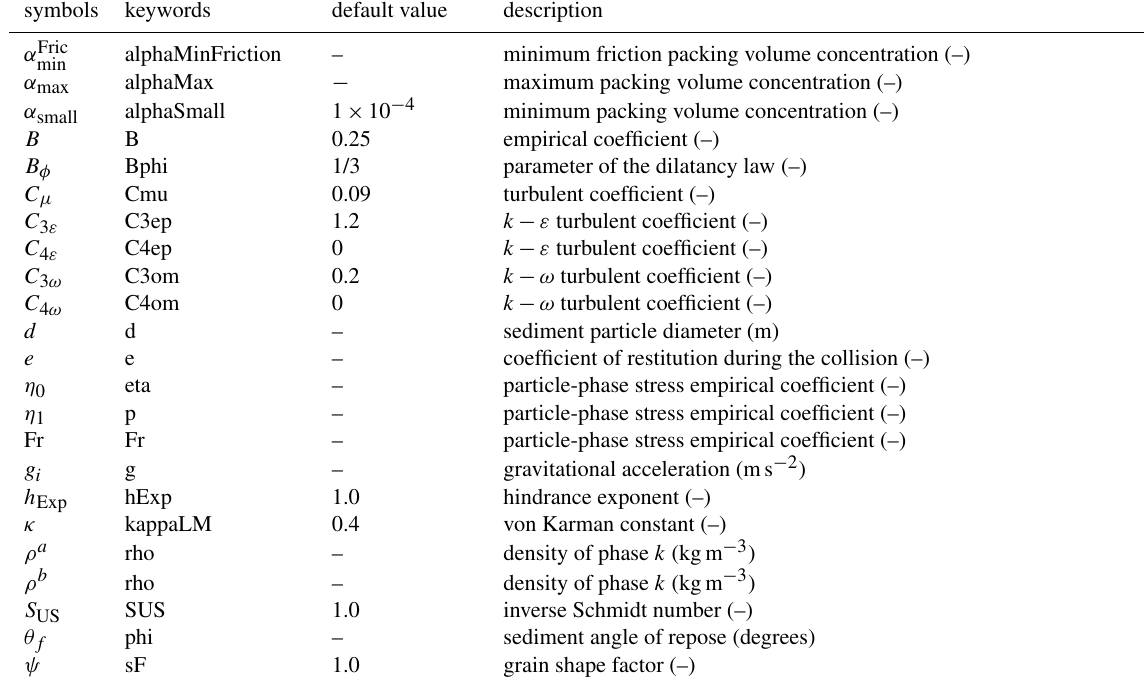
Table A2. List of the main model input parameters together with their default values when relevant.